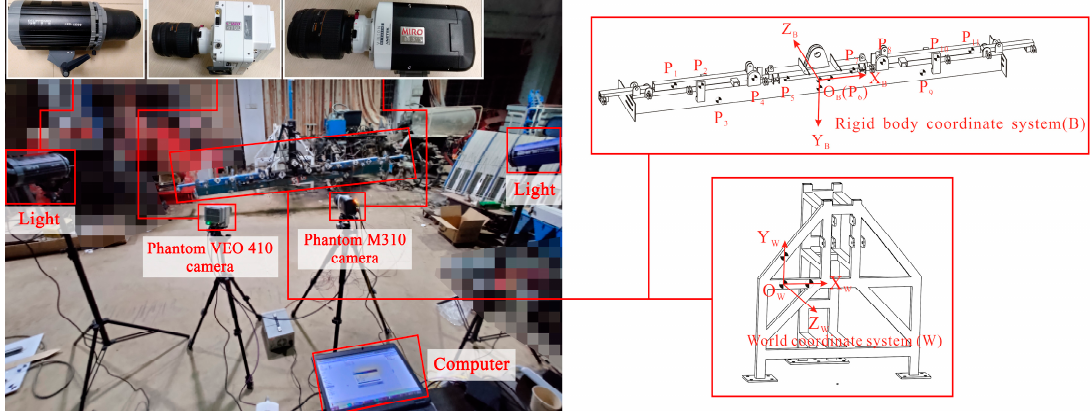
Figure 6. Experiment layout.